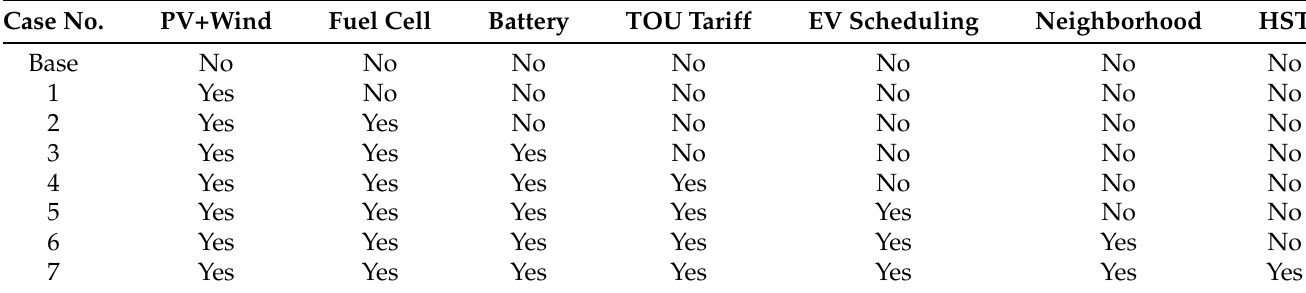
Table 4. Proposed test cases.